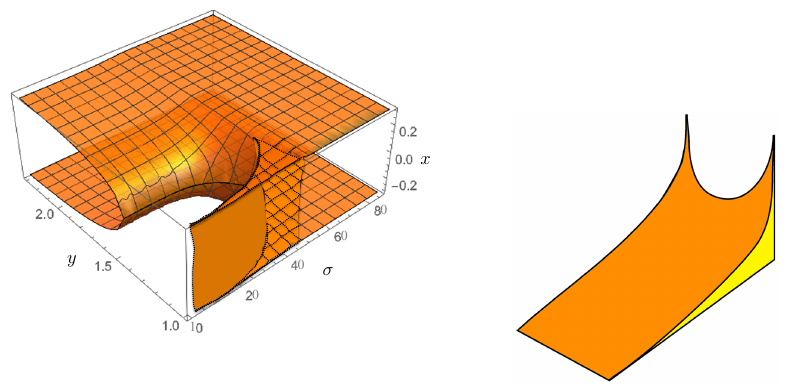
Figure 3 . On the left, a cartoon of a possible steady-state solution, where y = u/u T and ( x, σ ) = (4 πT/ 3)( x ) . On the right a very schematic rotated zoom on the trailing wall and its boundaries. 4 , z